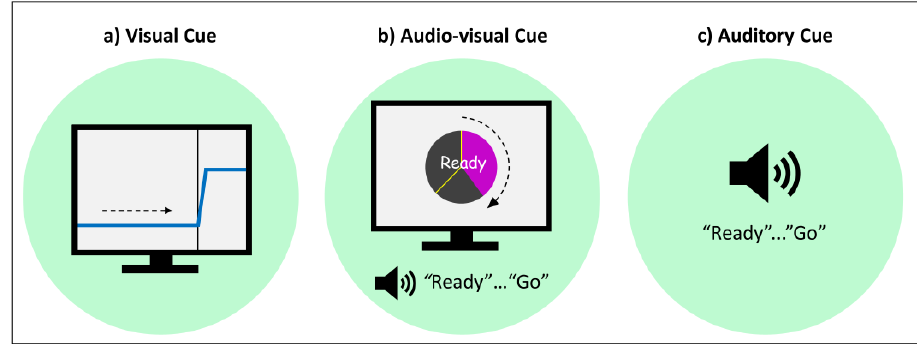
Figure 1. Movement